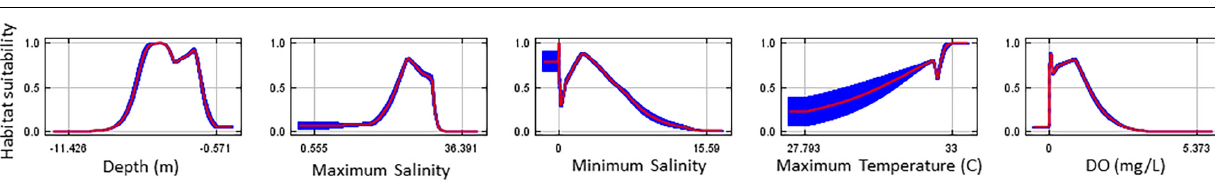
FIGURE 6 | Response curves for the environmental factors from the 10 replicant model runs. DO, dissolved oxygen. Red represents the mean and blue represents one standard deviation.